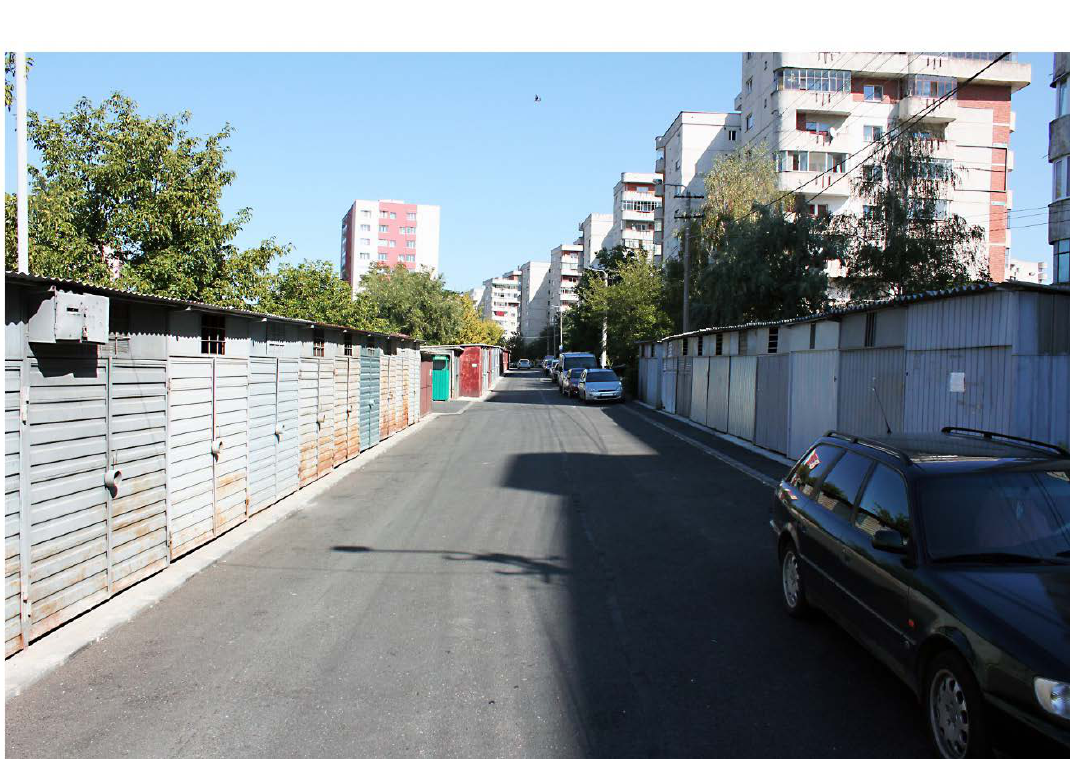
Figure 8: Garages in Mănăștur